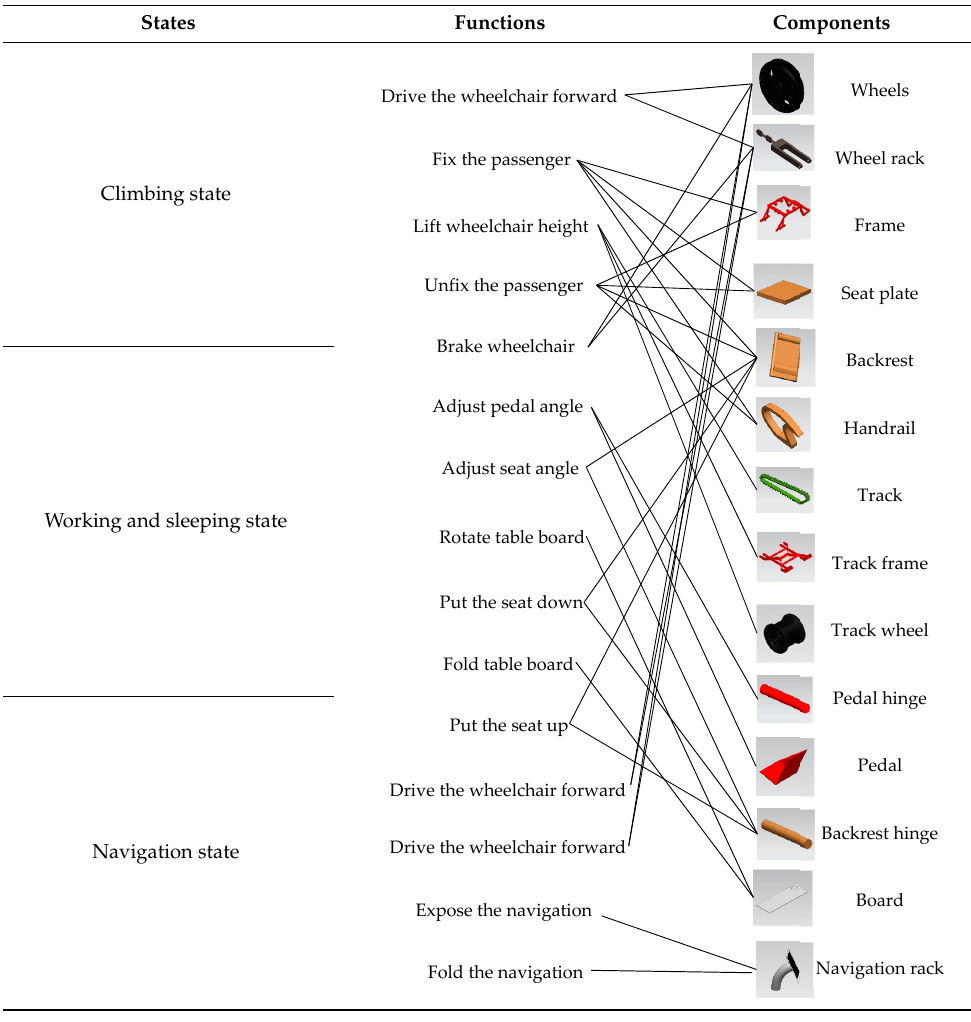
Table 7. Relationship between functions and components of the first concept.